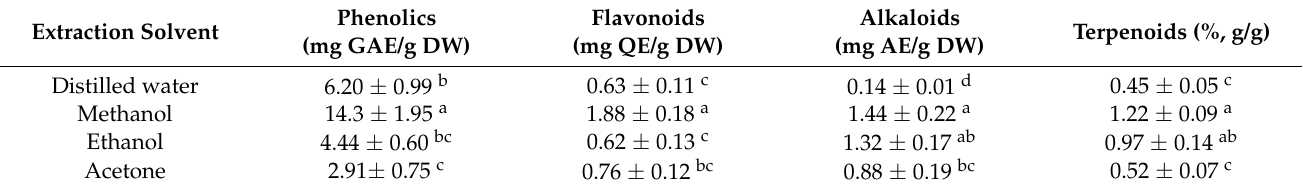
Table 2. Effect of different solvents on phenolic, flavonoid, and alkaloid content of Caralluma edulis. Extraction Solvent